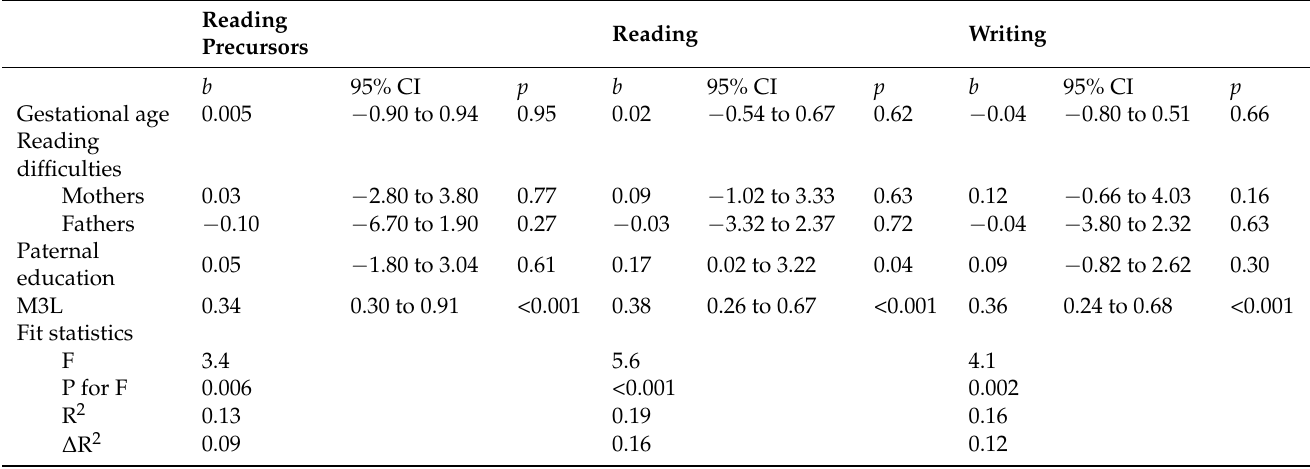
Table A2. Results of multiple variable linear regression analysis with reading precursors, reading, and writing skills at 7 years of age as dependent variables, and with M3L at 2 years of age and background factors as independent variables. Results of full-term controls are